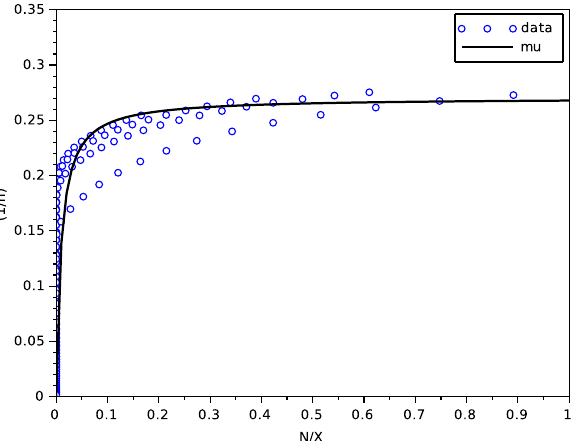
Figure 7. Result of the fitting of the Contois function on data from the SOFA model. Table 5. Parameters of the Contois function µ N .